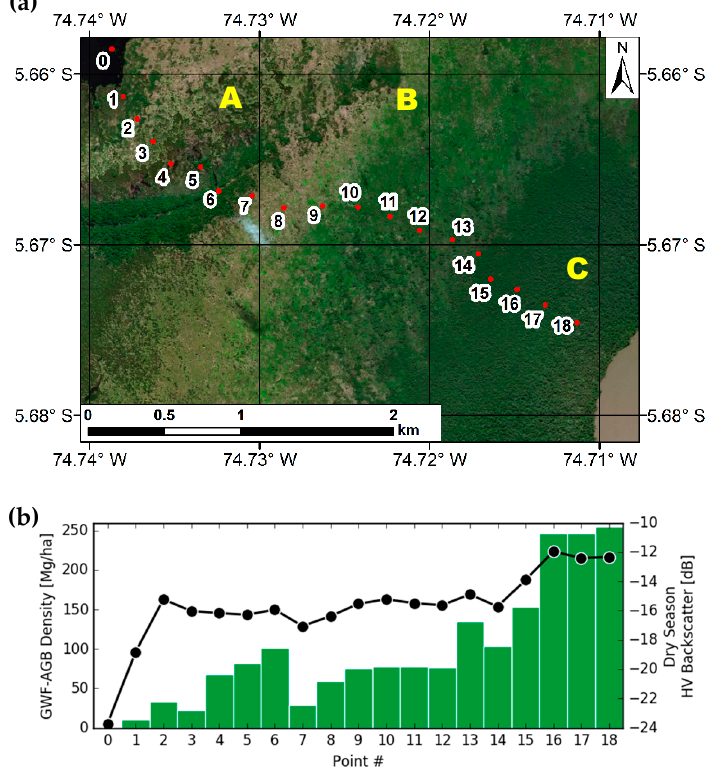
Figure 13. ( a ) Transect through inundated swamp; ( b ) GFW-derived AGB density (green bar, left axis) and HV-polarized PALSAR-2 ScanSAR backscatter (black line, right axis) for each point shown in transect. Three 0.01 ° × 0.01 ° grid cells of interest are labelled A, B, C in yellow.